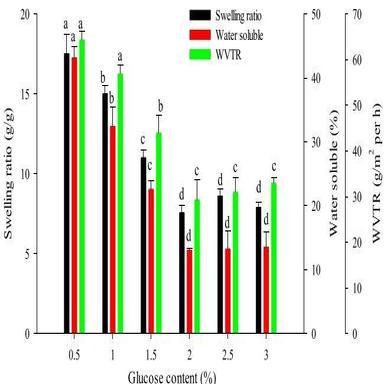
Swelling ratio, water soluble and WVTR of the cross-linked PPI/PUL NFs with various glucose content (different letters indicate significant difference (p < 0.05) within the same color column).